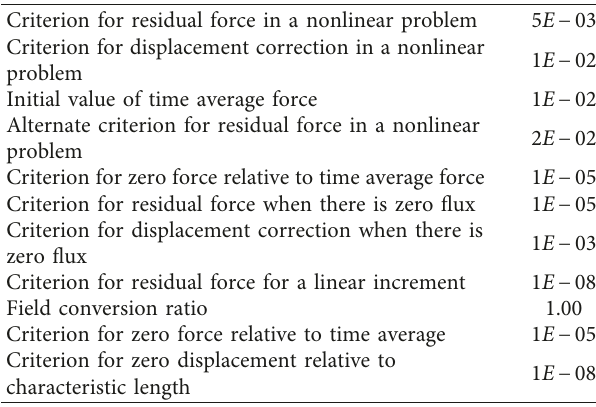
Figure 17 (unit: sec − 1 ) presents analytical results of the maximum principal strain rate at integration points. With comparison of Figure 14 to Figures 11 and 12, one can check that each analysis model is able to account for debonding behavior at the vertical interface with crack propagation.